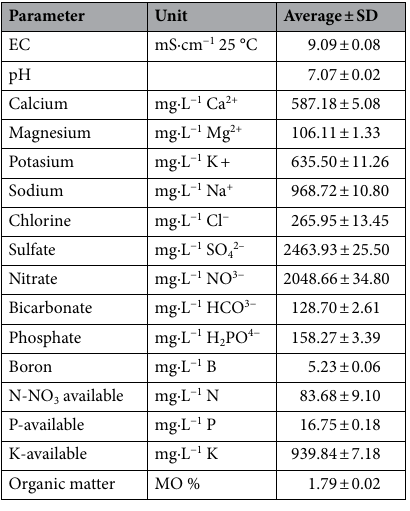
Table 1. Physical–chemical soil parameters of the bell pepper